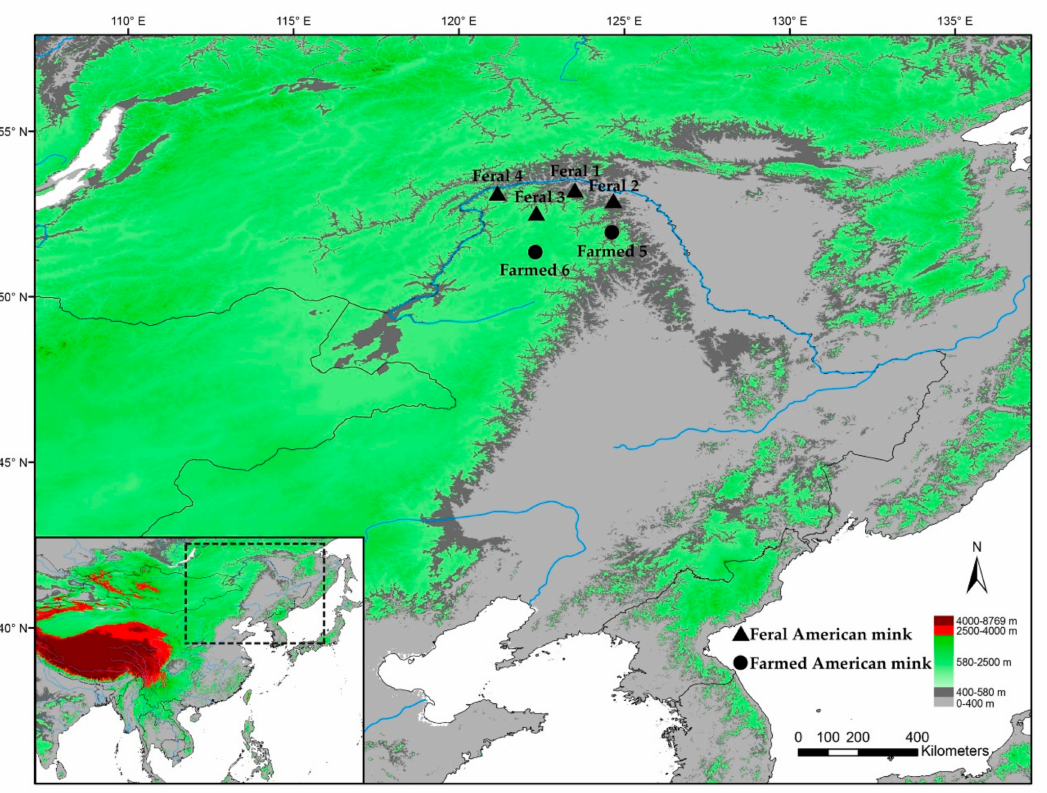
Figure 1. Map of the study area and sampling location of farmed and feral American